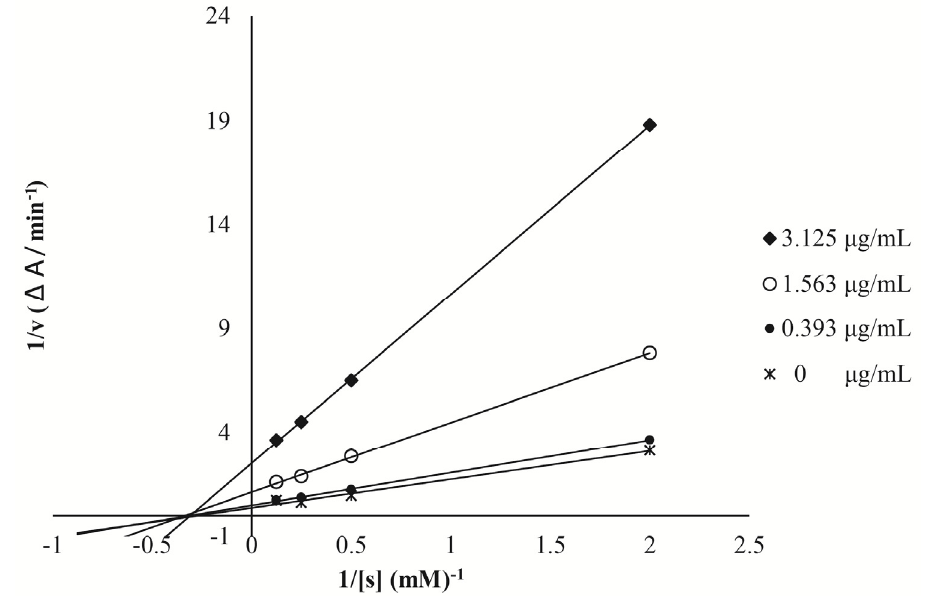
enzyme reaction was performed with different concentration of p NPG (0.5–8 mM) with different concentrations of